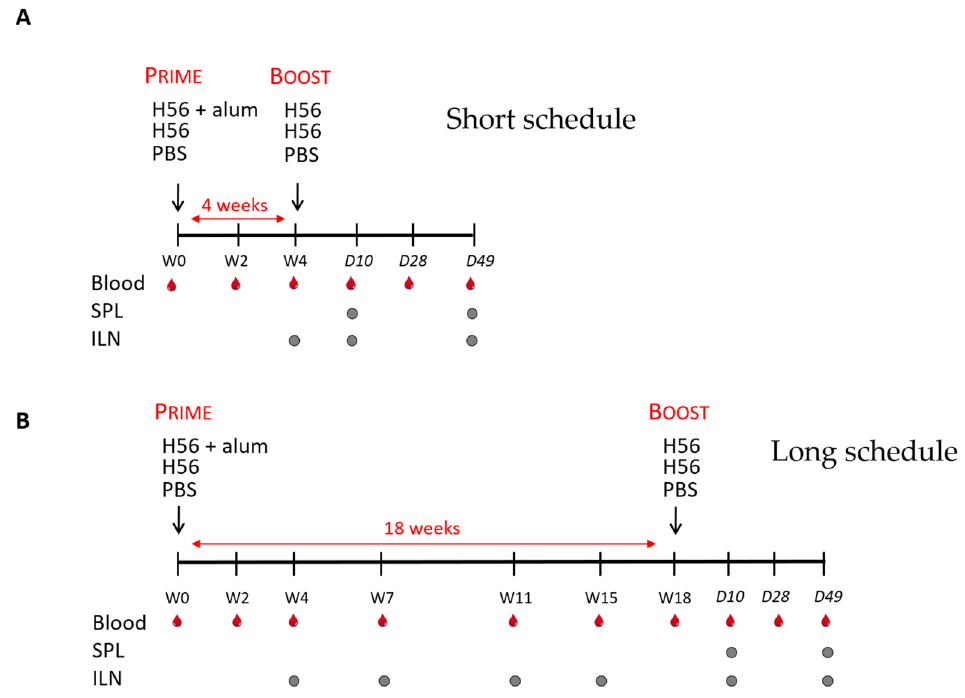
Figure 1. Experimental design. Two different immunization schedules ( A , B ) were tested and compared for the induction of serum antibodies (in blood), germinal center B cells, and antigen-specific T helper cells (in draining iliac lymph nodes, ILN), and cytokine production (in the spleen, SPL). C57BL/6 mice were subcutaneously immunized with the H56 antigen and alum and boosted with the antigen 4 ( A ) or 18 ( B ) weeks apart. Mice immunized with H56 antigen alone, or Phosphate Buffered Saline (PBS) were used as controls. Blood samples, ILN, and SPL were collected at the time points indicated by symbols. W, weeks; D, days.